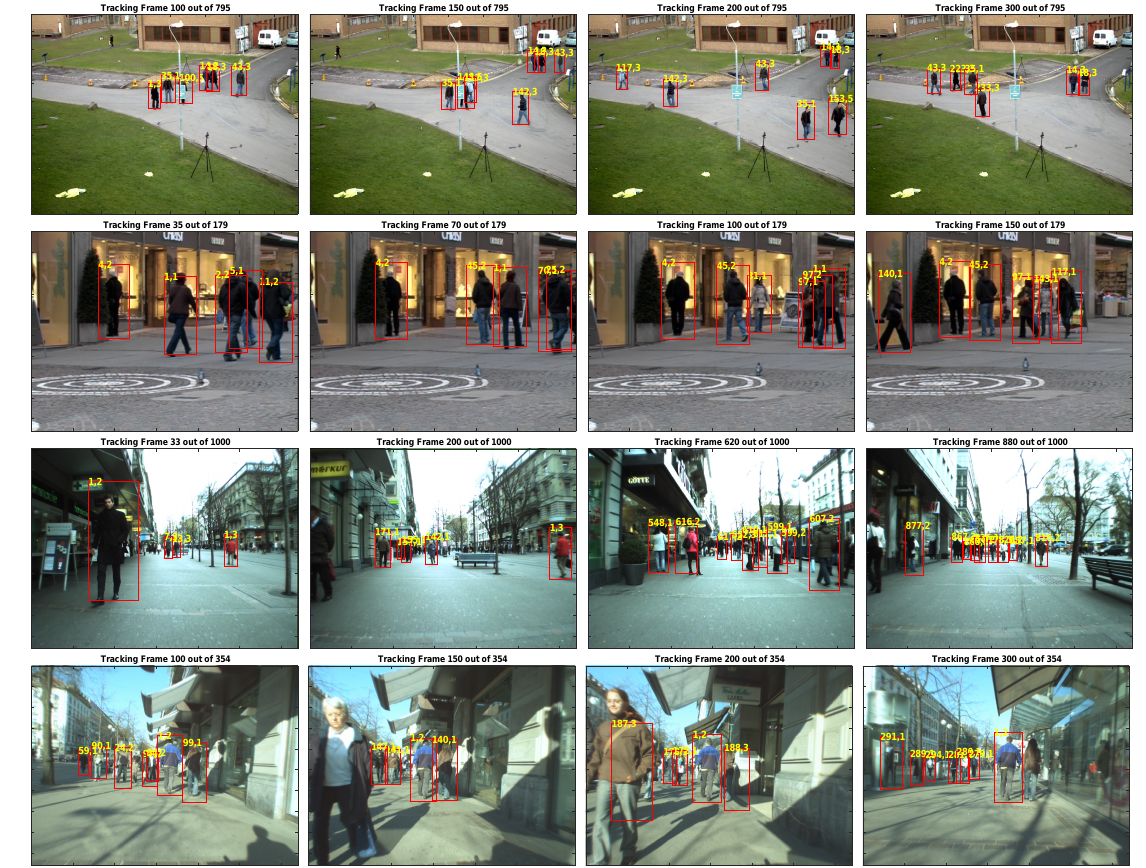
Figure 3. Tracking results for PETS2009S2L1V1, TUD-Stadtmitte, ETH Bahnhof and Sunnyday sequences. Examples for successful occlusion handling include pedestrians with labels; ( 142,2 ) in PETS2009S2L1V1—first row two middle images; ( 4,2 ) in TUD-Stadtmitte—second row all images; and ( 1,3 ) in ETH Bahnhof—third row first two images. Videos for the results presented are included as supplementary